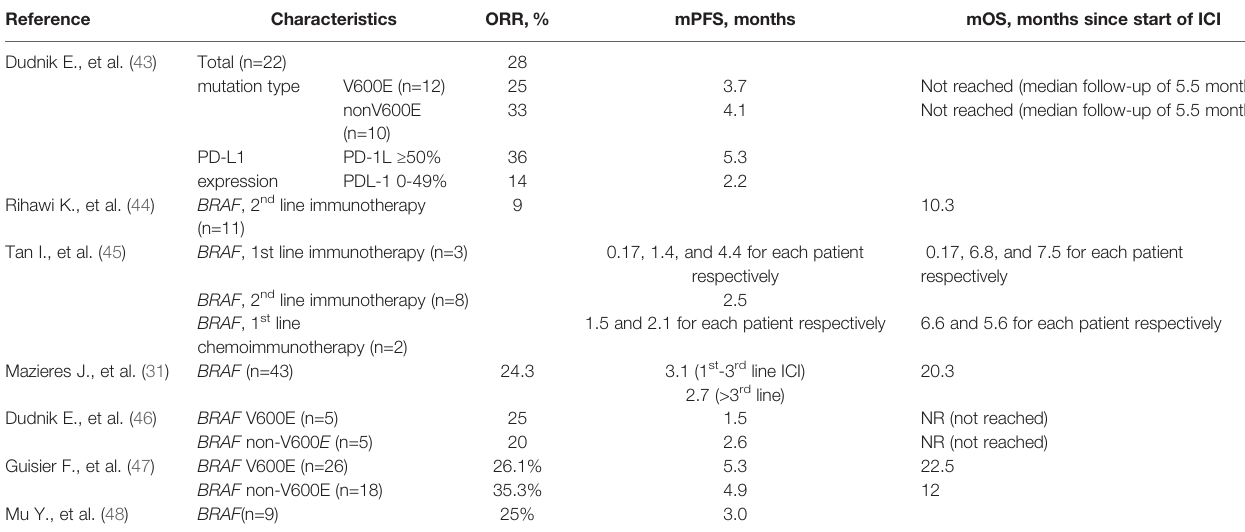
TABLE 2 | Ef fi cacy of ICIs in NSCLS with BRAF